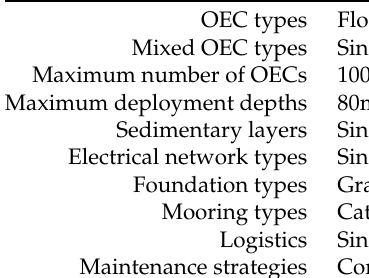
Table 1. Simulation scope and modelling assumptions of the DTOcean software. Reproduced from